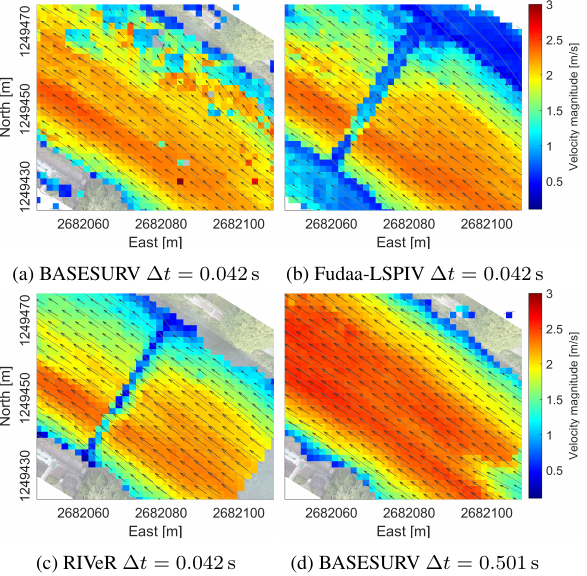
Figure 6. Time-averaged SVFs computed from dataset B. For